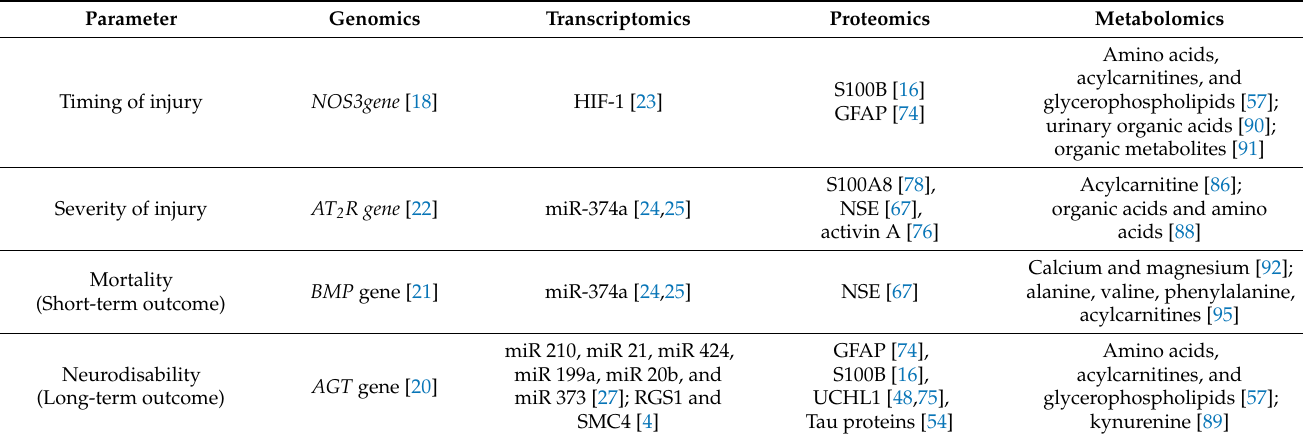
Table 4. Application of multi-omics approaches for predicting the timing and severity of the injury and short-term and long-term outcomes in